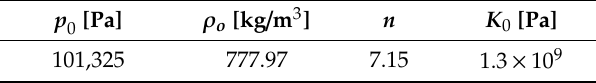
Table 2. Reference values used in Tait